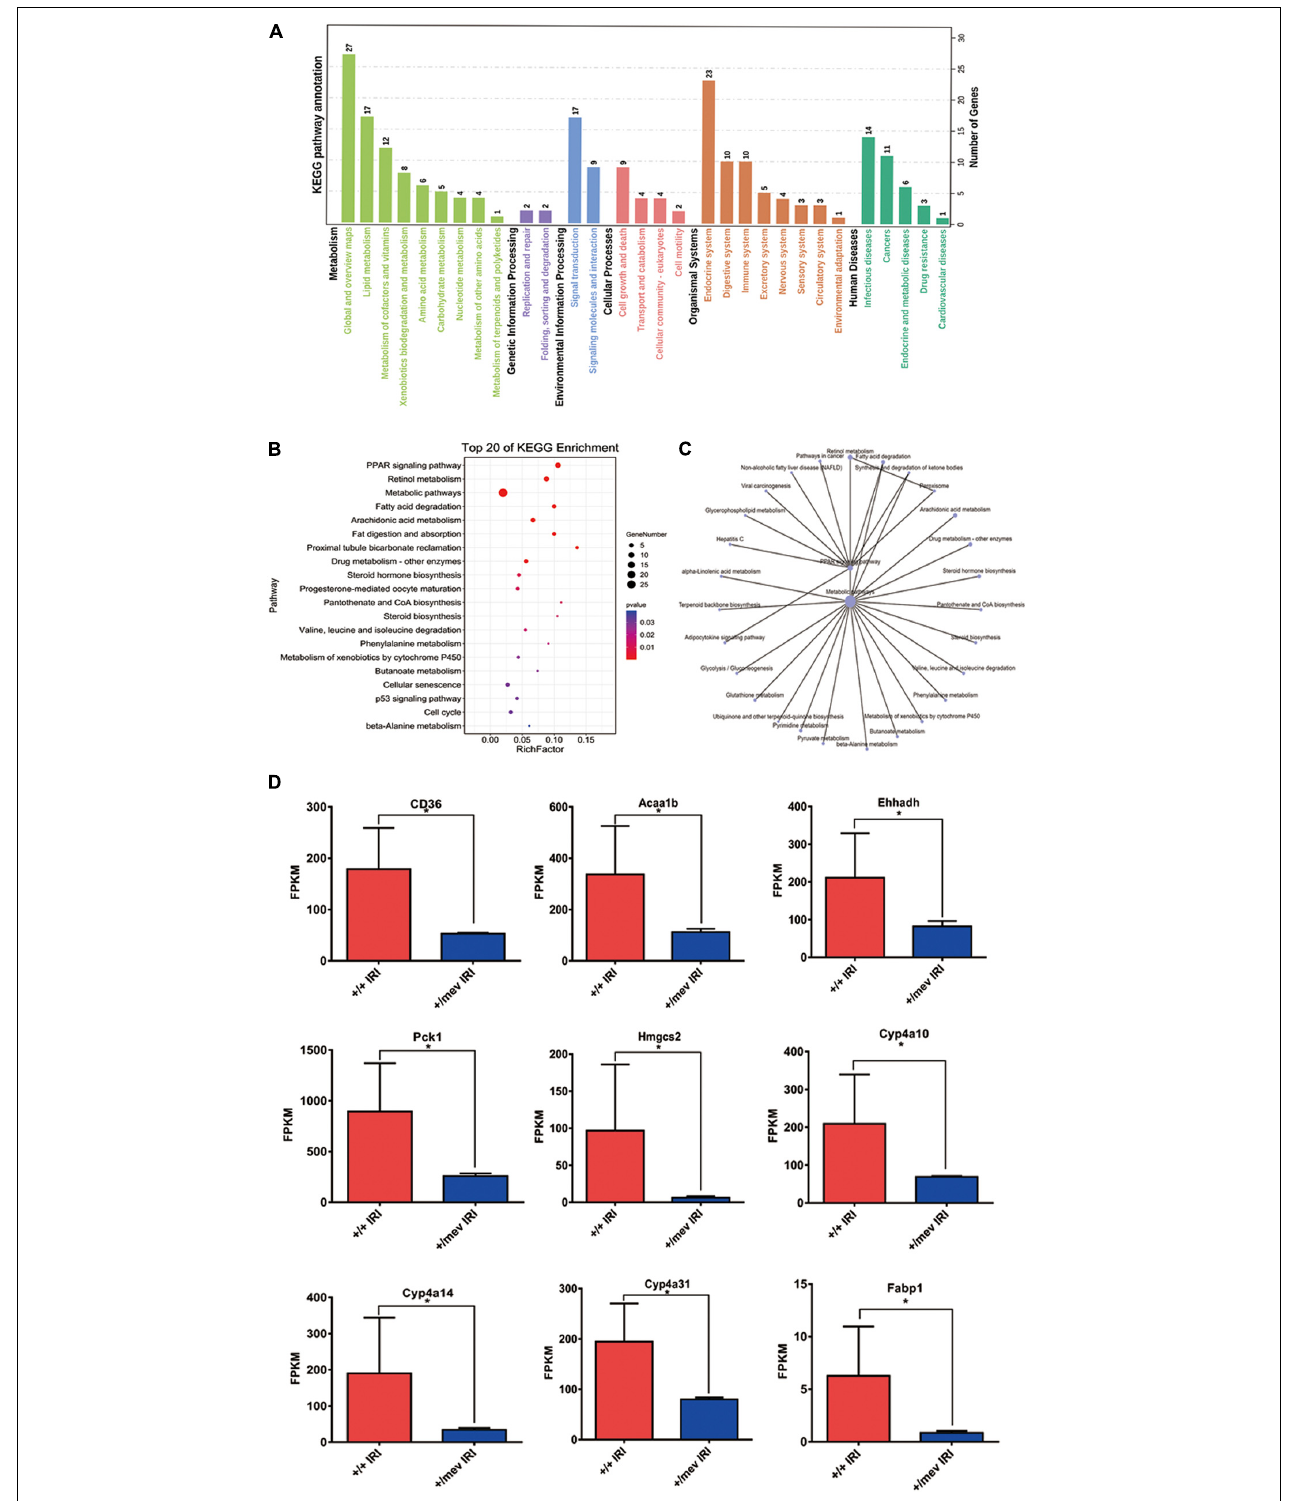
FIGURE 3 | Kyoto encyclopedia of genes and genomes (KEGG) analysis of all DEGs and the expression of PPAR α signaling pathway related genes. (A) KEGG pathway annotation of all DEGs. (B) The top 20 enriched KEGG pathways of all DEGs. A larger rich factor indicates a higher degree of enrichment. The plot is plotted with the pathways ranked by P -value from smallest to largest for the top 20. (C) KEGG enrichment network diagram of all DEGs. (D) The expression of PPAR α signaling pathway related genes were obtained by RNA-seq analysis. * p < 0.05.